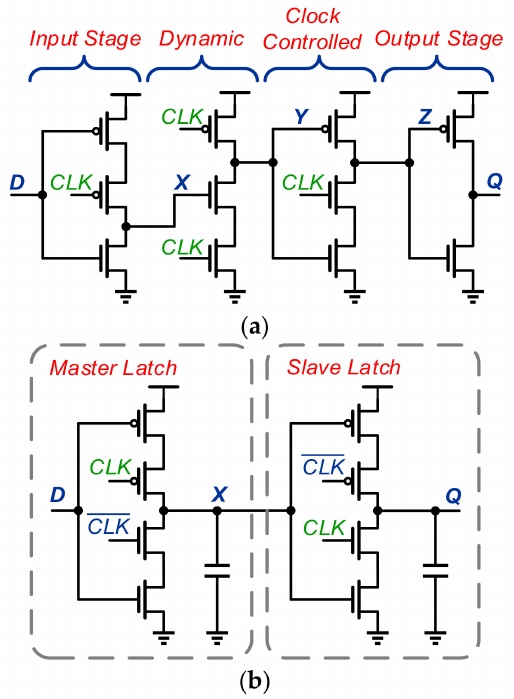
Figure 3. Schematic diagram of two common D flip-flops: ( a ) TSPC-DFF; ( b ) C 2